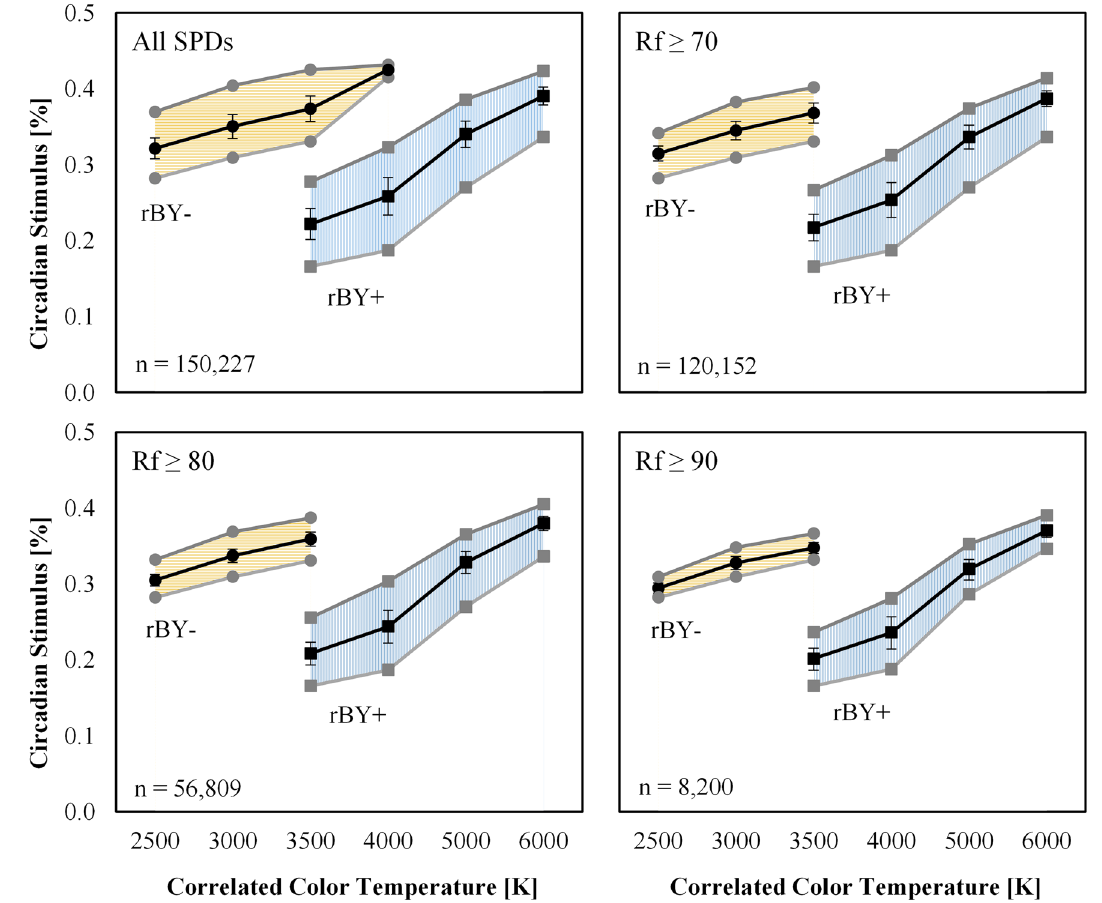
Figure 8. Circadian stimulus (CS) as a function of nominal CCT at a photopic illuminance of 300 lx. (Top left) All SPDs for the “Filtered” dataset. (Top right) The “Filtered” dataset further filtered for R f ≥ 70. (Bottom left) The “Filtered” dataset further filtered for R f ≥ 80. (Bottom right) The “Filtered” dataset further filtered for R f ≥ 90. “rBY-” indicates the “yellow wins” scenario of the CS model (also indicated by the horizontal hatching and circle markers); “rBY+ ” indicates the “blue wins” scenario of the CS model (also indicated by the vertical hatching and square markers). Lines show the maximum (grey), minimum (grey), and average (black) CS within each nominal CCT; error bars indicate the standard deviation. On average, sources with rBY- have higher CS values than sources with rBY+. The b-y spectral opponency causes the observable discontinuity near 3500 K where the model switches from one hypothetical model of phototransduction to another. As the average fidelity floor is raised (i.e., from R f ≥ 70 to R f ≥ 80 to R f ≥ 90), the achievable CS range